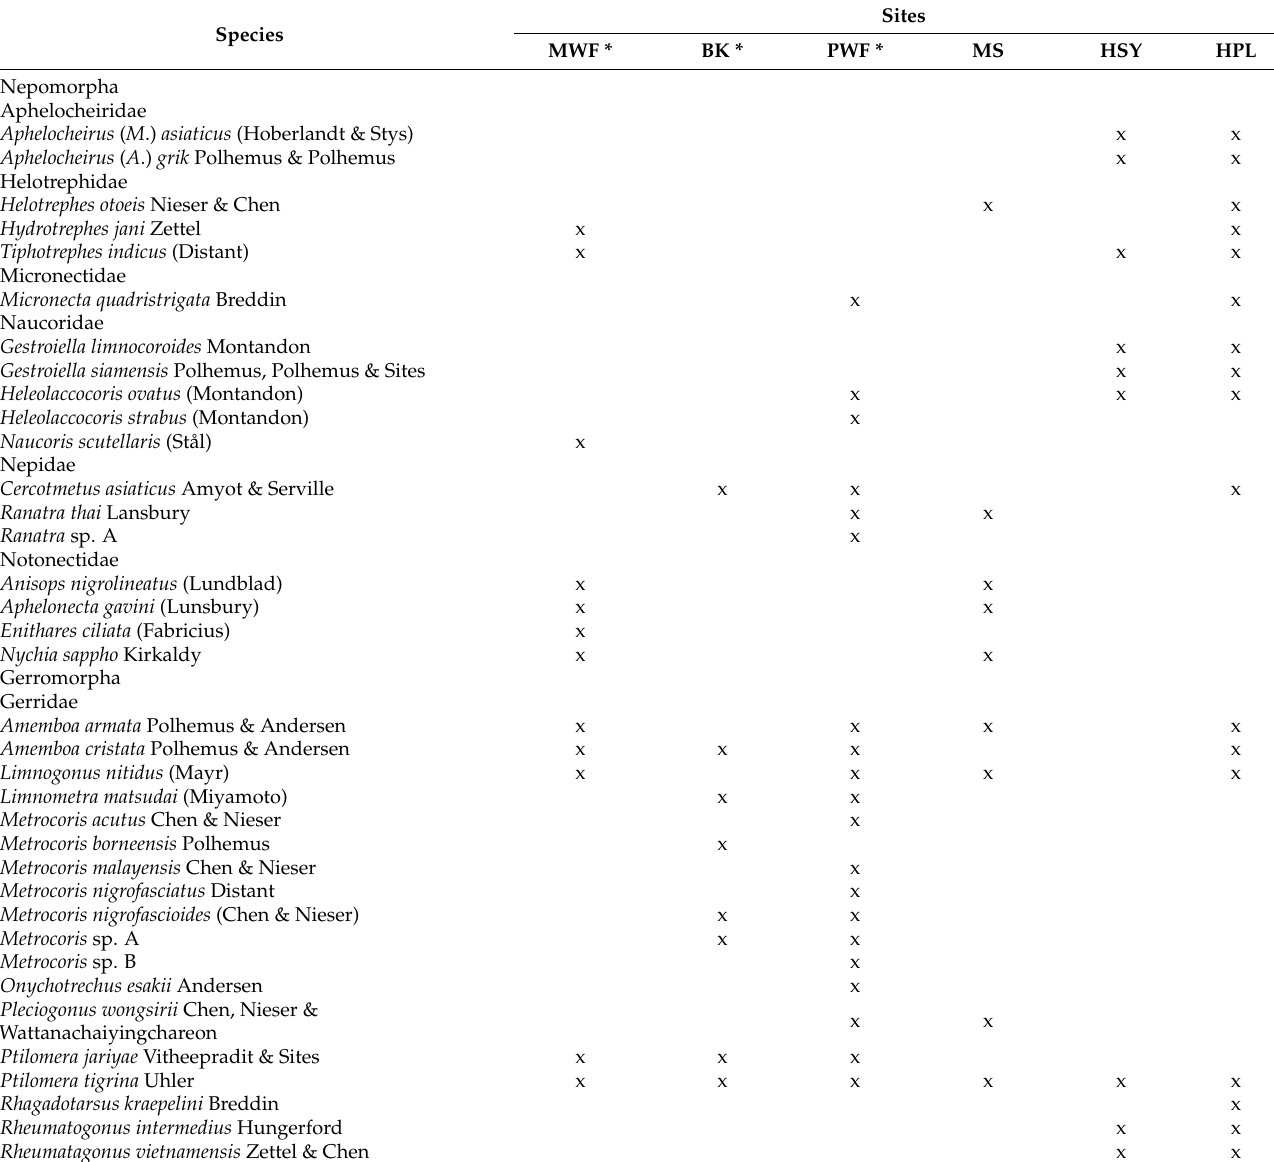
Table 2. Taxa collected from protected sampling sites located inside the national park and uprotected sampling sites located outside the national park. * = protected sampling